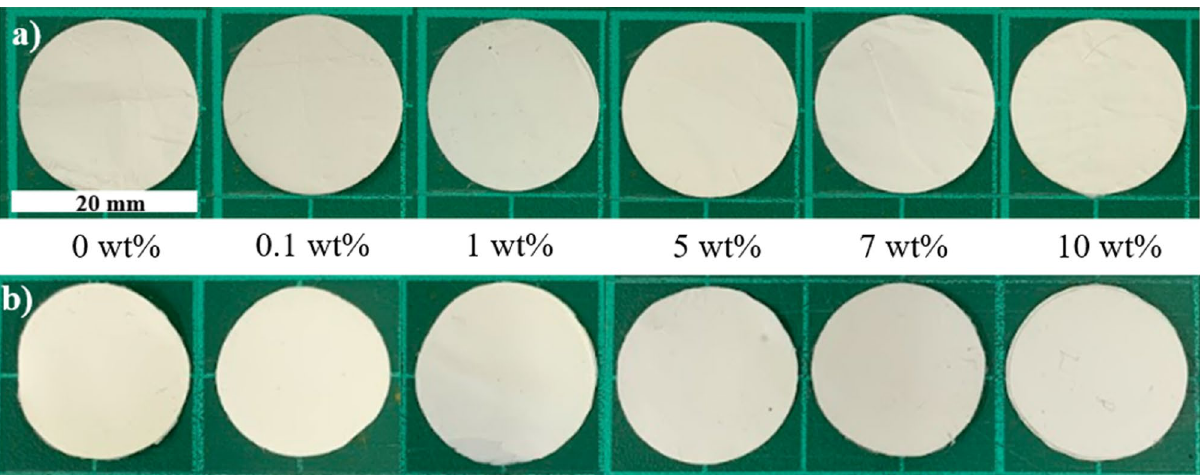
Figure 11. PAN/bio-based PU/Ti 3 C 2 T x MXene composite ( a ) before and ( b ) after heating at 150 °C for 1